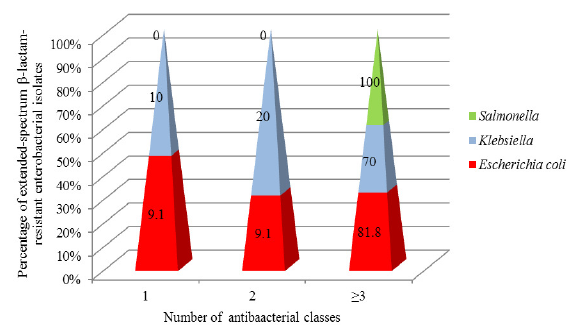
Fig. 4. Antibiogram of 5 generic extended-spectrum β-lactam- resistant Salmonella isolates from dogs